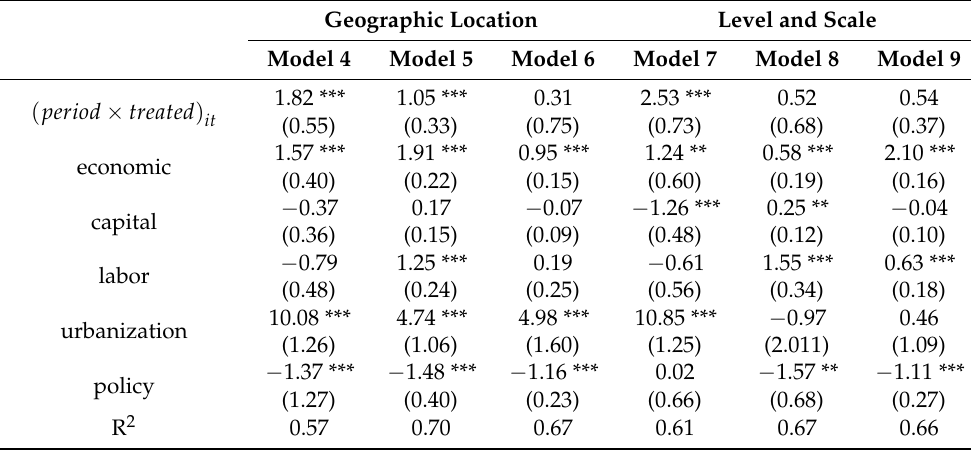
Table 3. Regression results of regional heterogeneity. Geographic